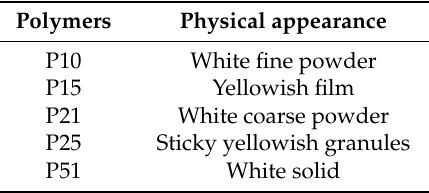
Table 2. Physical appearance of synthesised disulphide polymers.